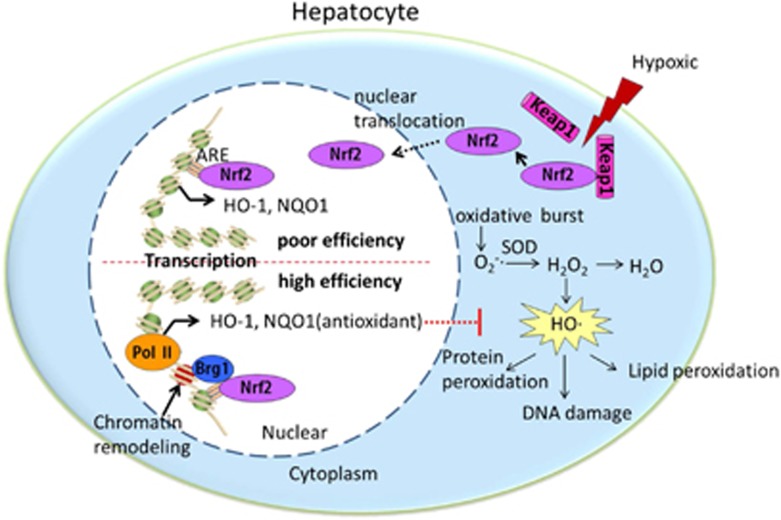
Proposed signaling of Brg1-mediated Nrf2/HO-1 pathway activation in HIR injury. Keap1 dissociation from Nrf2 leads to Nrf2 translocation from cytoplasm to nucleus during HIR injury. However, with poor efficiency, hepatocyte could not produce enough antioxidant HO-1, which is the downstream target gene of keap1/Nrf2 pathway. Upregulation of the chromatin remodeling factor Brg1 could enhance transcription factor Nrf2 binding to HO-1 DNA sequence and promote HO-1 generation in a high efficiency way. Antioxidant enzyme HO-1 then suppresses the free radical generated from oxidative burst during hepatocyte H/R injury